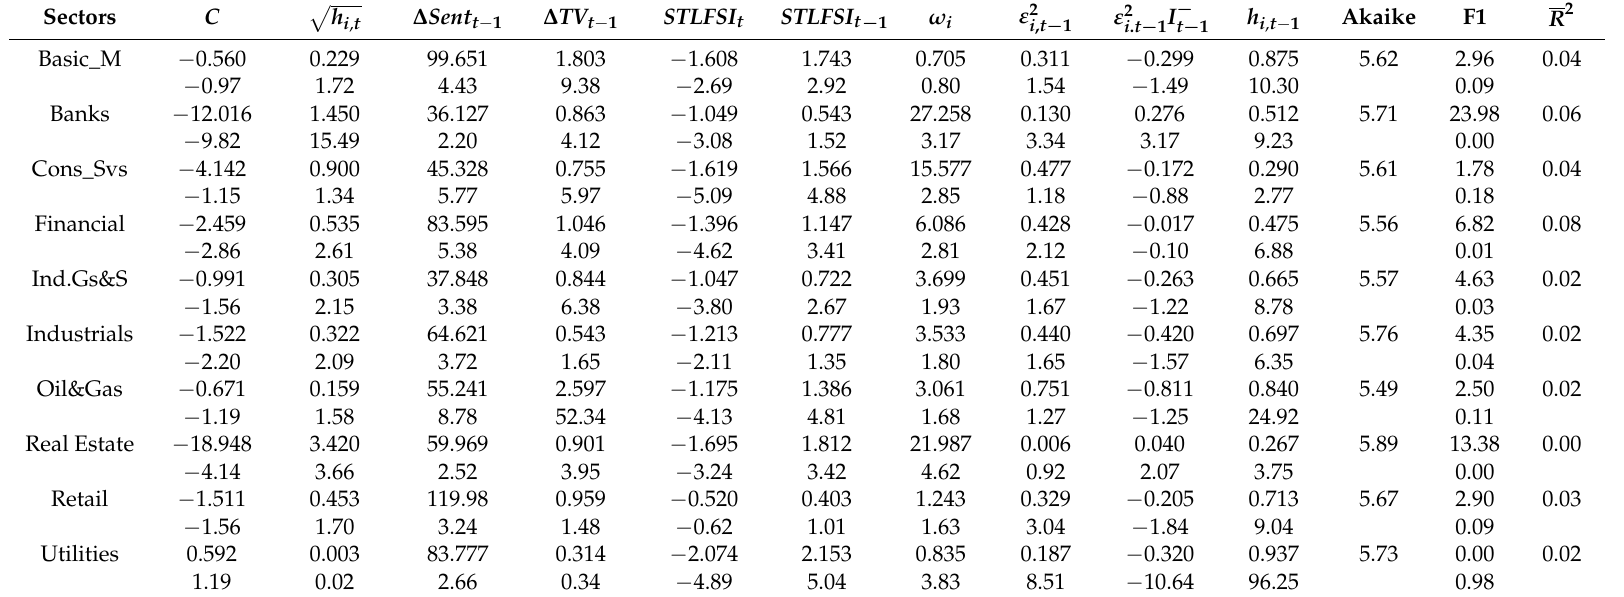
Table 4. Estimates of stock returns on downside risk, U.S. market stress, sentiment, and liquidity with a GED-TARCH-M